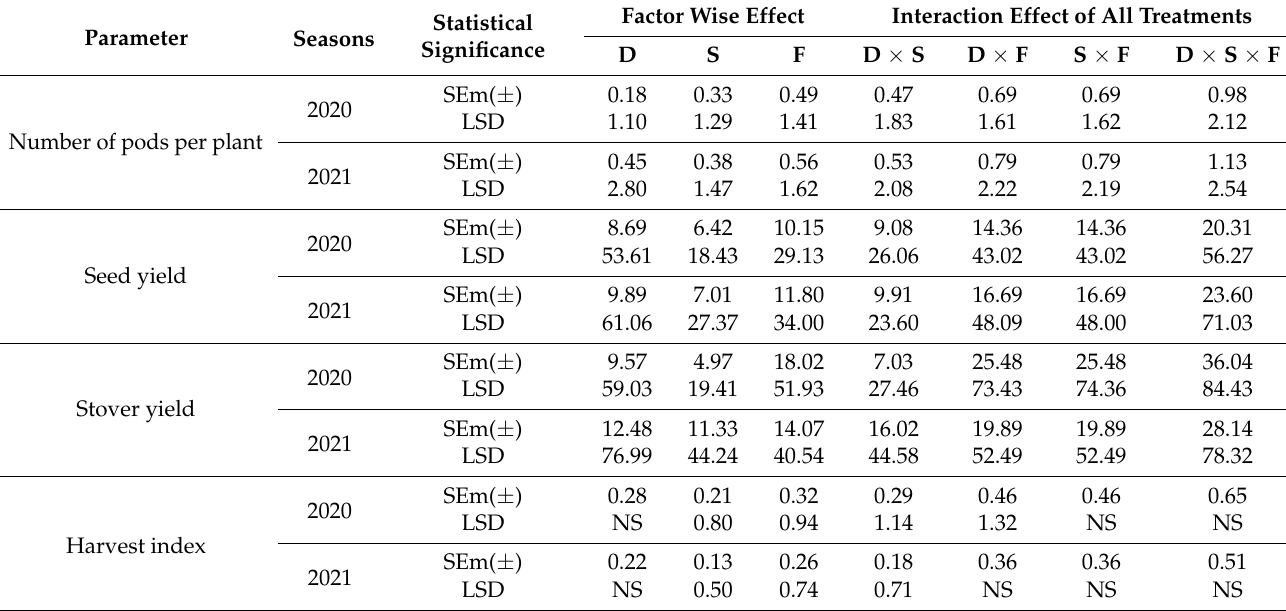
Table 12. Statistical significance and interaction effects of date of sowing, soil application of Co and foliar spray of K and B on the yield characteristics of black gram during spring–summer season.